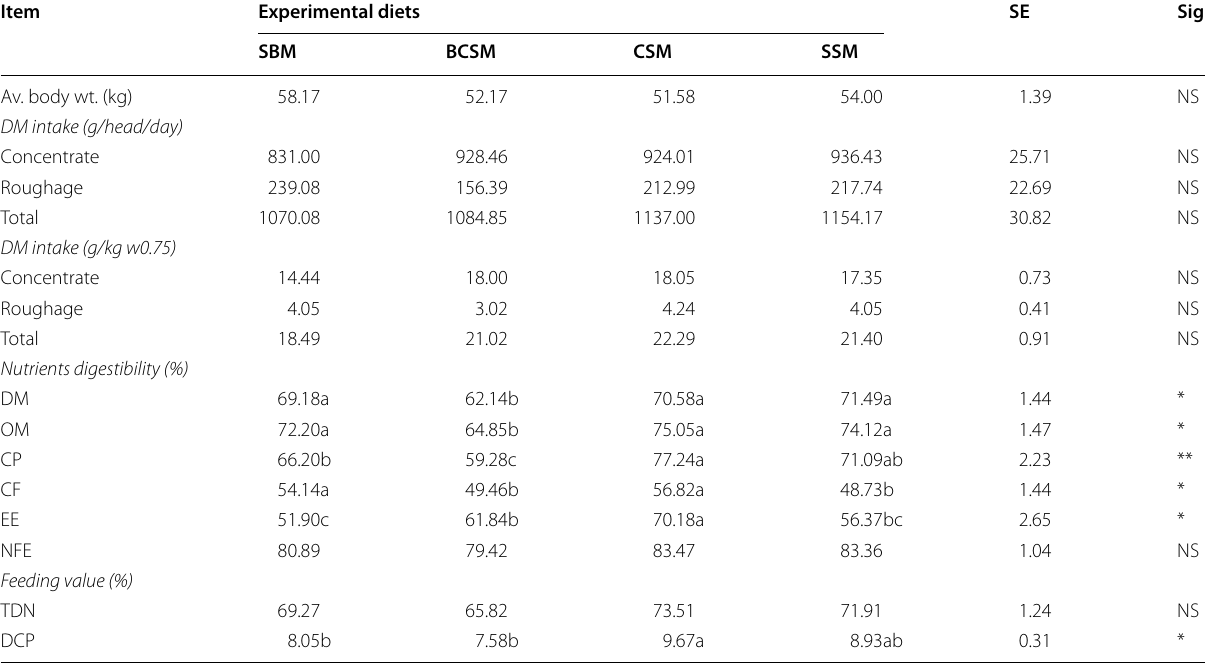
a, b and c: Means in the same row with different superscripts are significantly different at ( p < 0.01) SE, standard error; NS, nonsignificant difference *: Significant difference at ( p < 0.05). **: Significant difference at ( p <